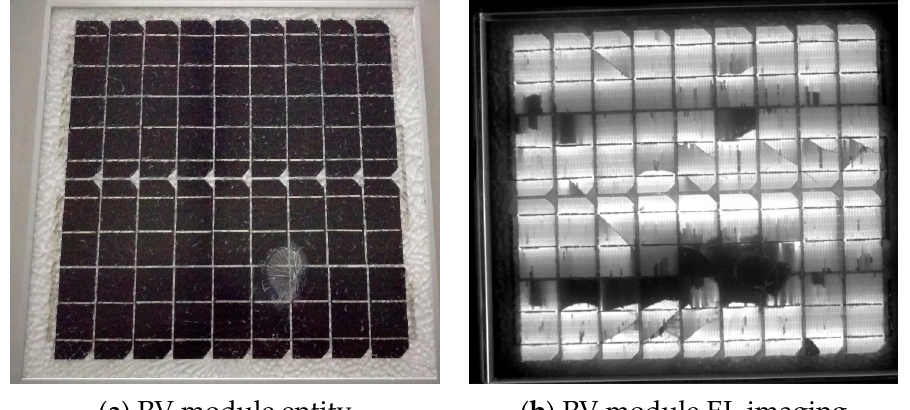
Figure 7. Partial failure of the built PV module.